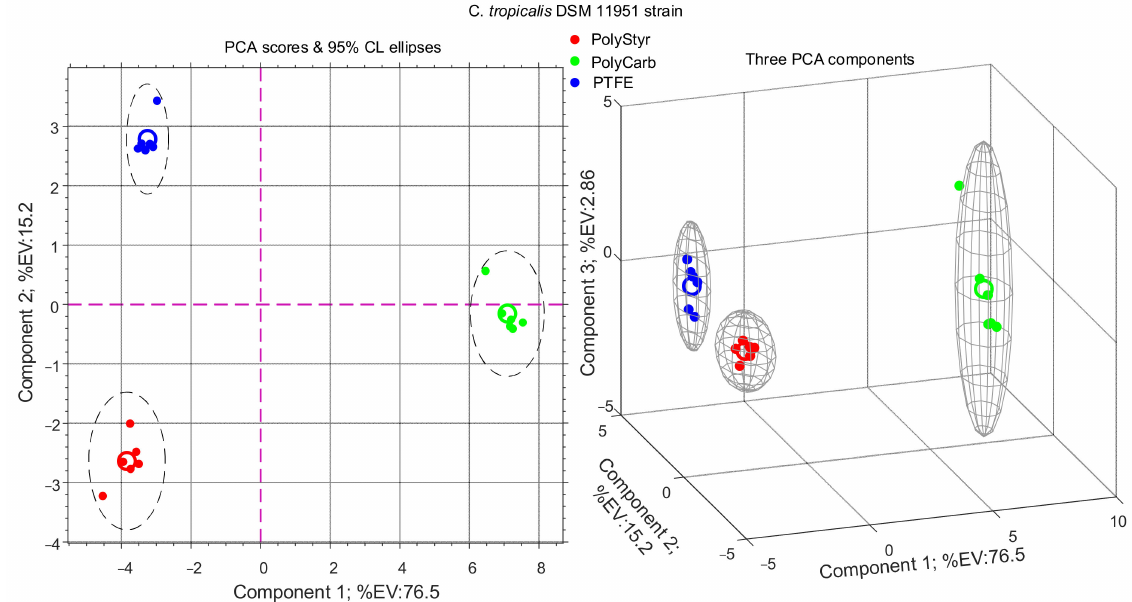
Figure 2. PCA analysis of intracellular metabolites extracted from cells of Candida tropicalis DSM 11951 strain harvested from biofilms grown (72 h) on polystyrene (PolyStyr class), polycarbonate (PolyCarb class), and Teflon (PTFE class).